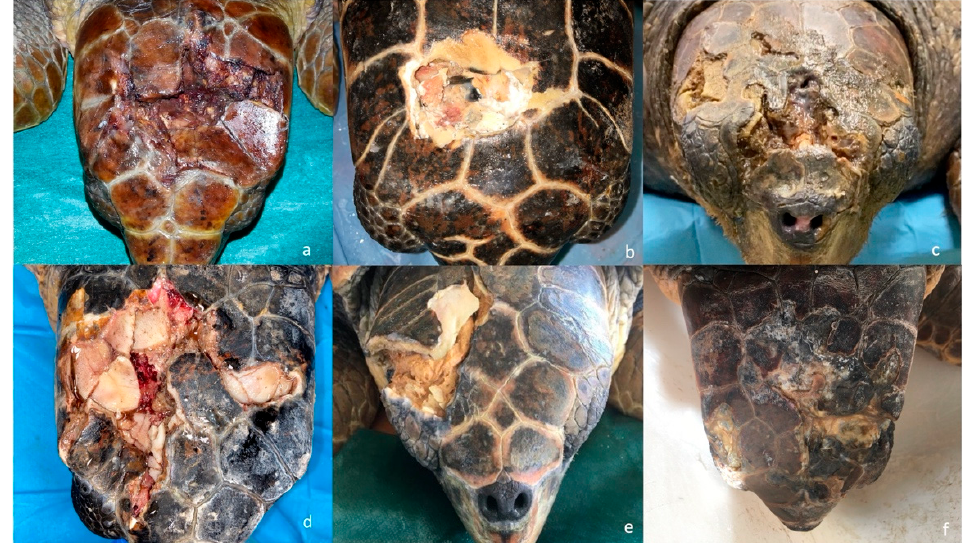
Figure 1. Head trauma staging example ( a ) Clinical assessment of a grade 3 skull trauma; ( b ) X-ray in latero-lateral view showing parietal and postorbital fractures; ( c ) 3D-CT scan of the same turtle’s skull showing the same clinical pattern and the compromised right ocular globe.